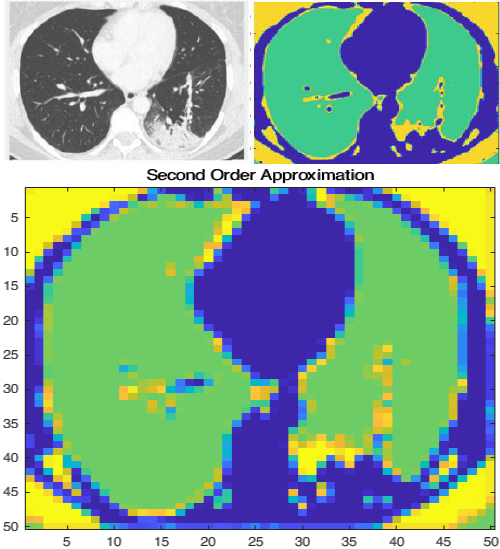
Figure 6. Original and Filtered Image ( top ) and second-order approximation of wavelet transform ( bottom ).